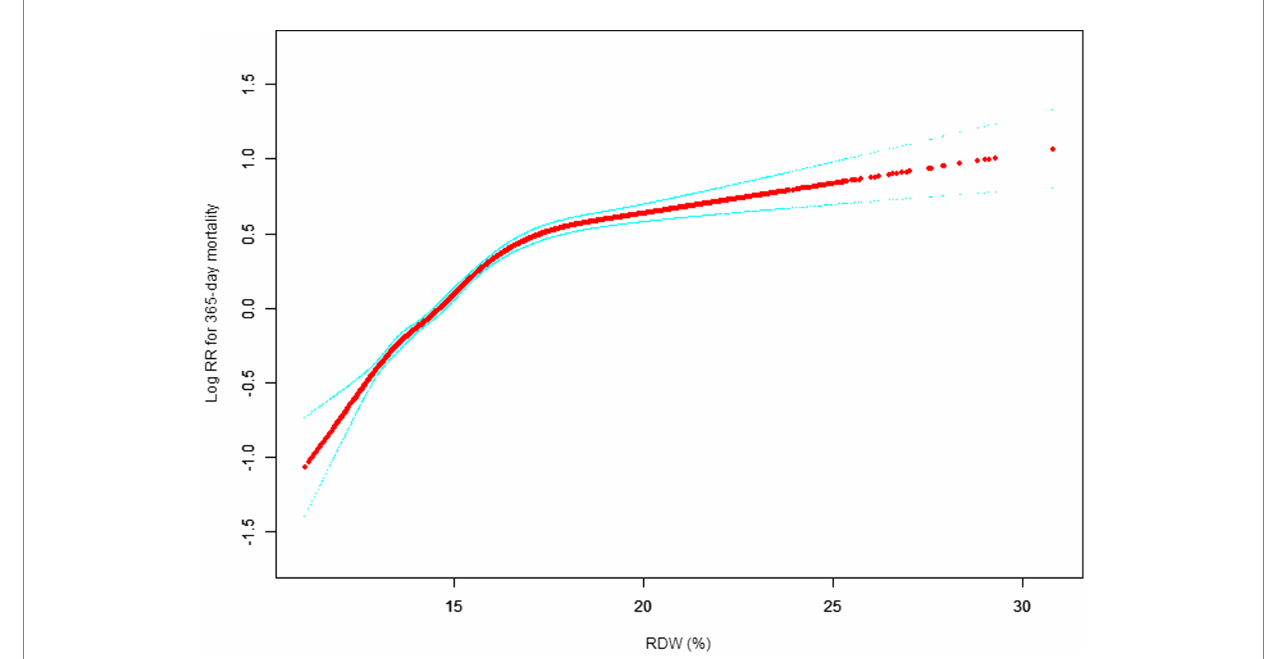
FIGURE 4 Association between RDW and 365-day all-cause mortality. (After adjustment for other covariates). A generalized additive model (GAM) revealed a threshold, nonlinear relationship between RDW and 30-day mortality. The smooth curve fit between variables is shown by a solid red line. The 95% confidence interval from the fit is represented by imaginary blue